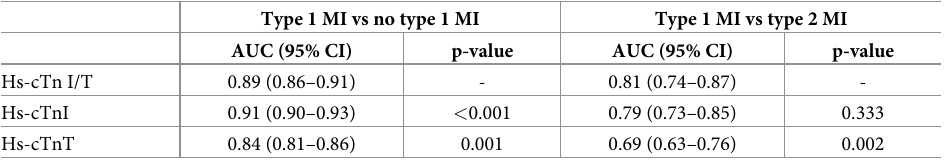
Table 2. Discriminative value of the hs-cTn I/T ratio compared to hs-cTnI or hs-cTnT.